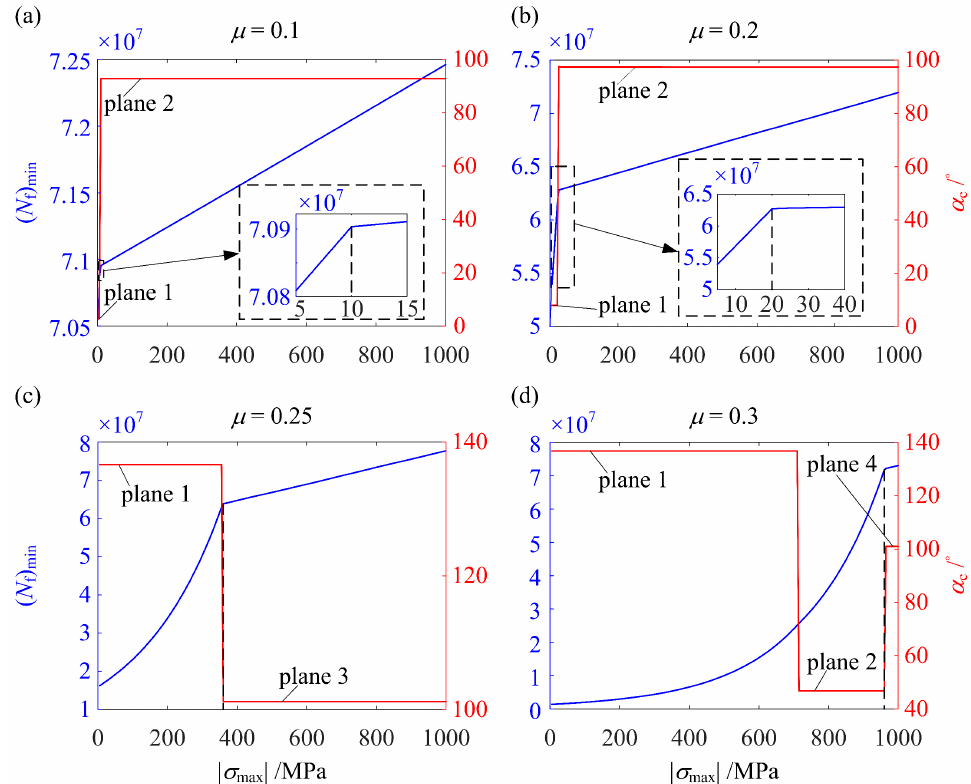
Figure 13. The effect on ( N f ) min and α c when σ max deviates from ( σ max ) opt = − 1000 MPa for P / P rated = 1 and ( a ) μ = 0.1, ( b ) μ = 0.2, ( c ) μ = 0.25, and ( d ) μ = 0.3.